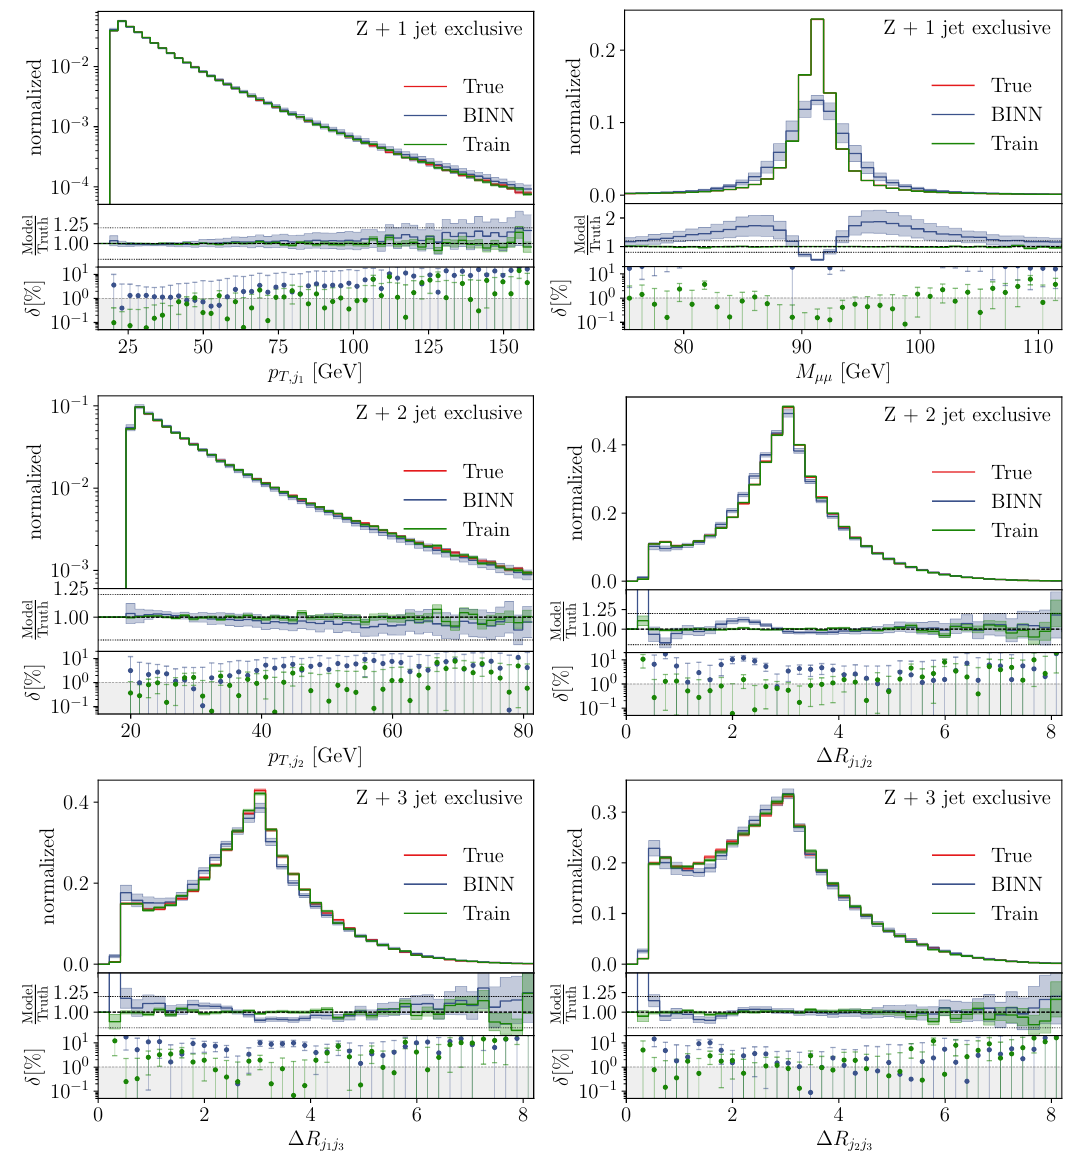
Figure 11: BINN densities and uncertainties for Z + 1 jet (upper), Z + 2 jets (mid- dle), and Z + 3 jets (lower) from a combined Z + jets generation. The architecture and training data correspond to the deterministic network results shown in Fig. 4, including the magic transformation of